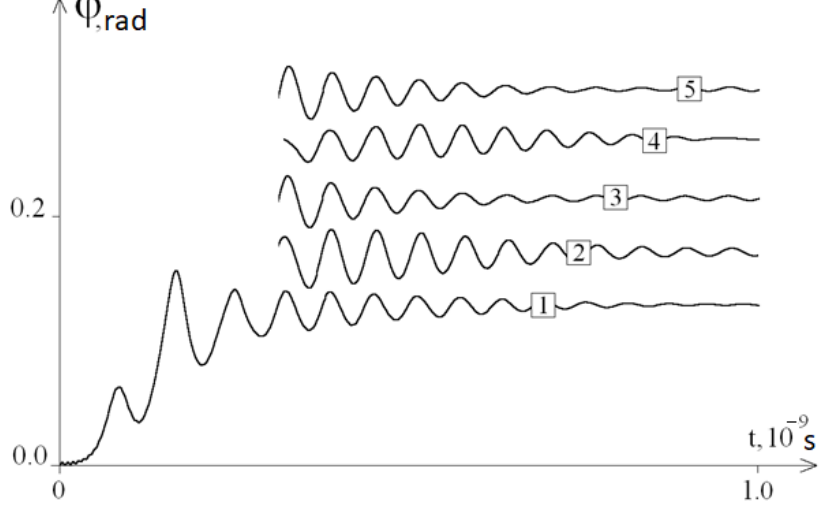
Figure 5. The average angular deviations (with a vertical shift) of the first DNA chain at ω = 10 8 s − 1 of the initial DNA (1) and fragments of the graphs for DNA with replacement with (2) 40A, (3) 40 T, (4) 40 G, and (5) 40 C.